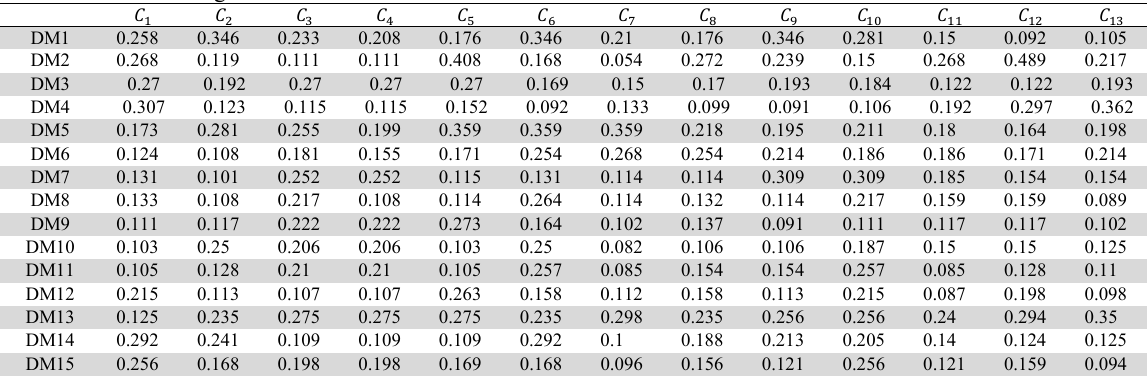
The final values of weight